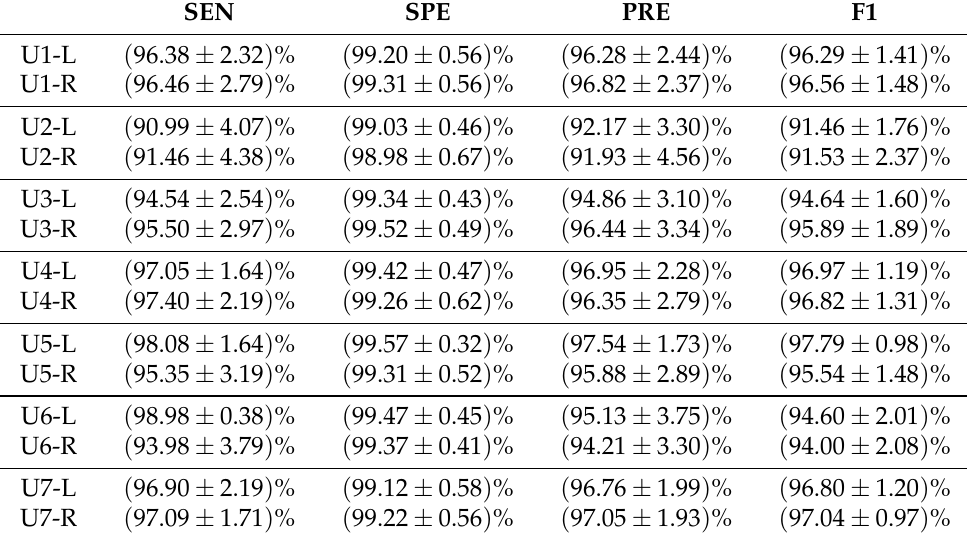
Table 5. Evaluation metrics for the left (L) and right (R) carotid artery and for each user. SEN